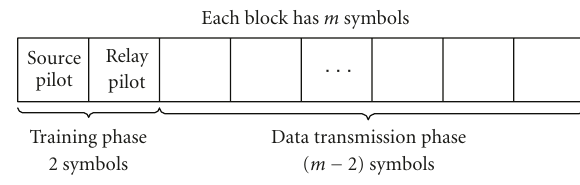
Figure 2: Transmission structure in a block of m symbols.